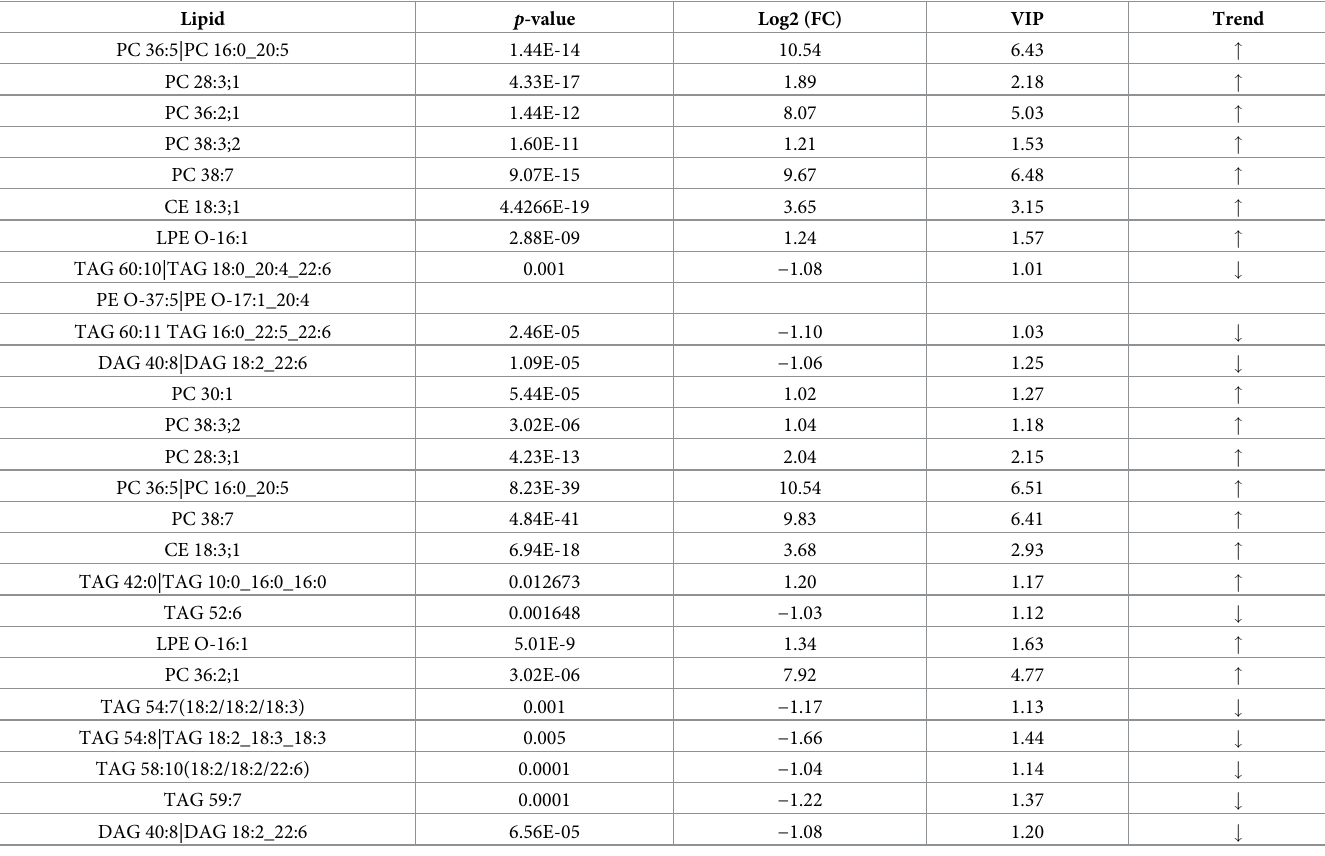
Table 1. Potential biomarkers between TBEV patients and the healthy control group. Lipid p -value Log2 (FC) VIP